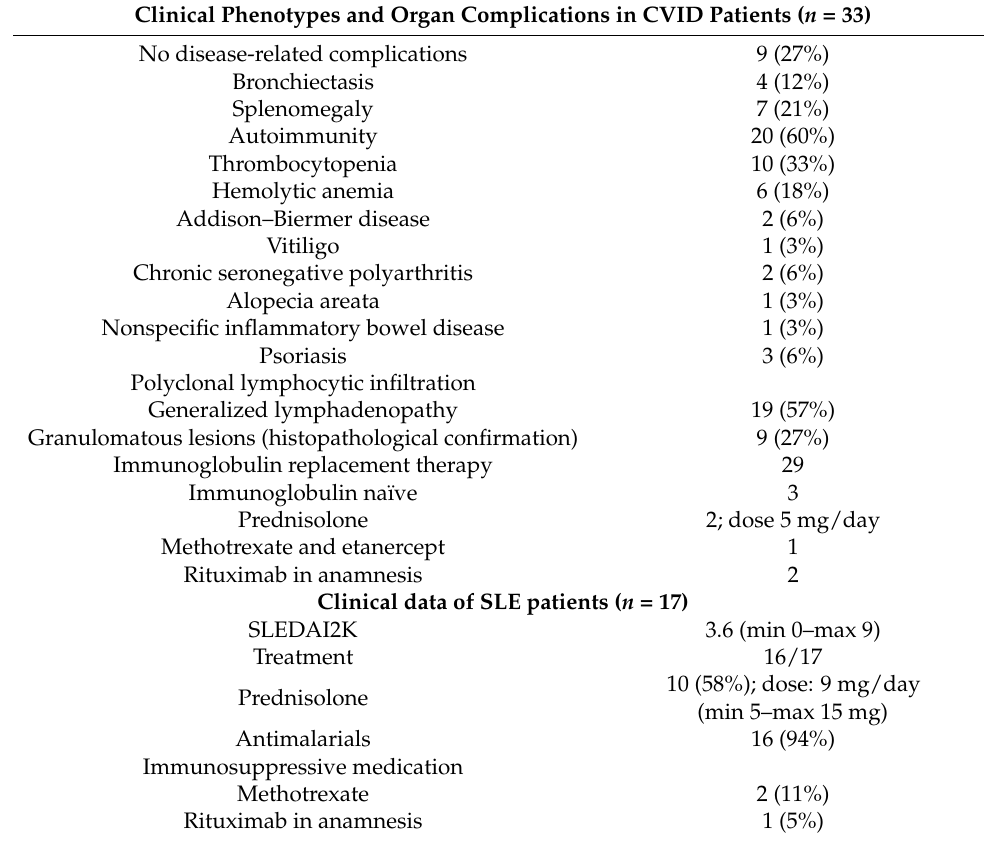
Table 1. The clinical characteristics of patients with CVID and